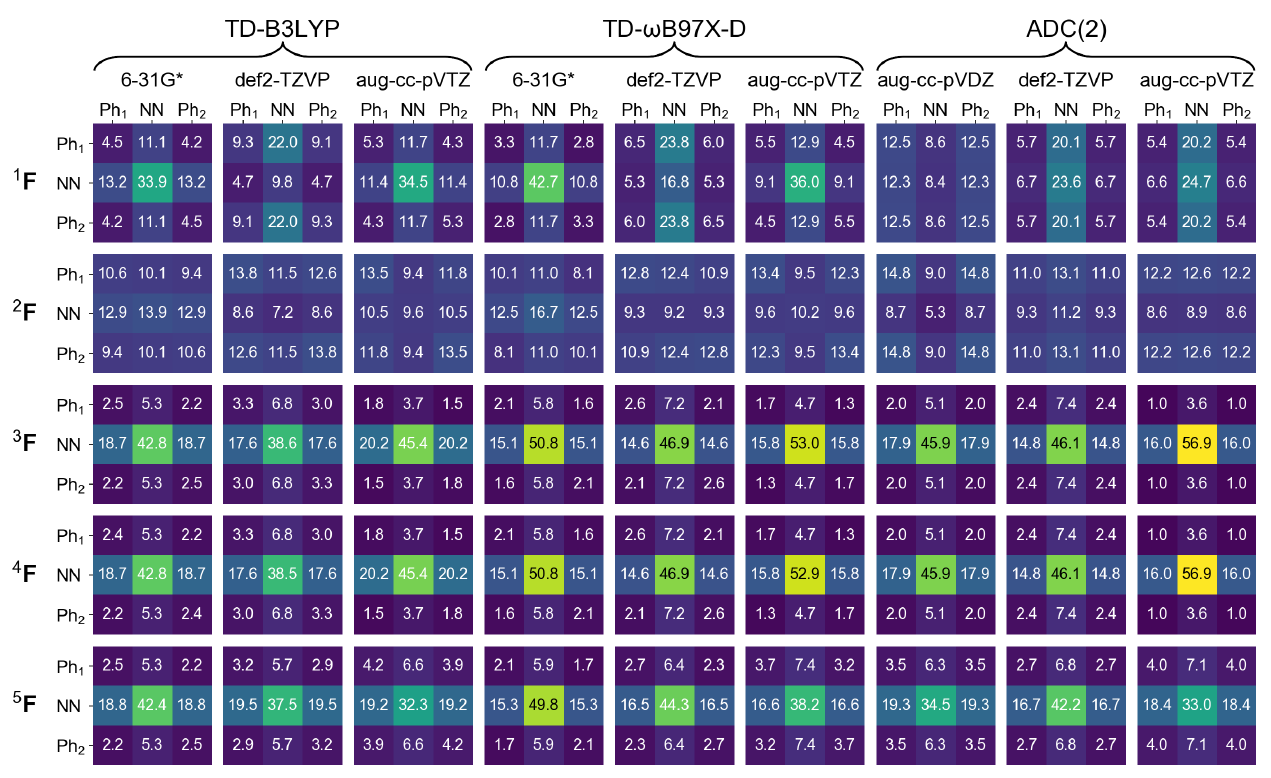
Figure 2. FTDM matrices 1 F , . . . , 5 F for the S 0 → S 1 transition of azobenzene calculated with nine methods indicated in the top. FTDM elements are expressed in %, i.e., multiplied by 100.